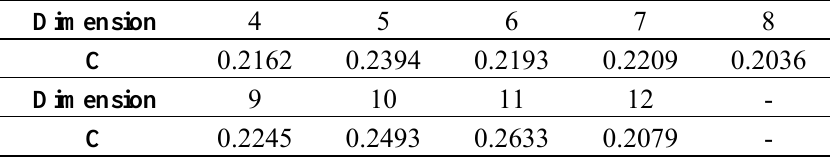
Table 3. Dimensions and a posteriori error ratios using the discrete grey forecasting model DGM